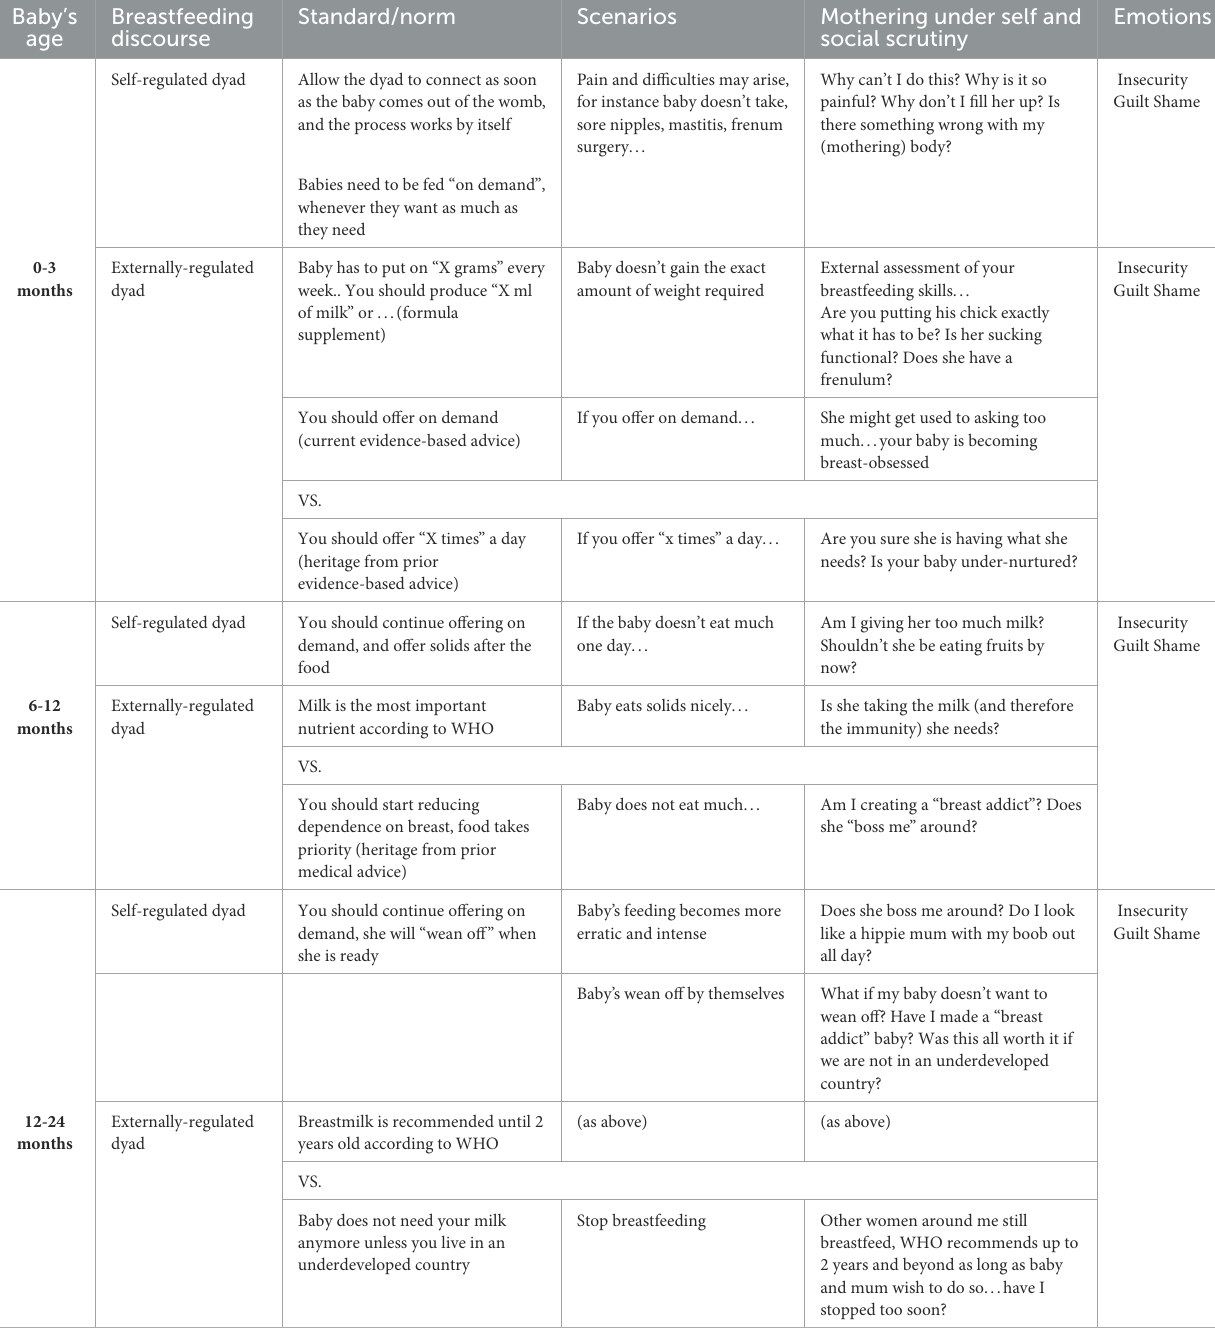
TABLE 1 Breastfeeding as the initiation act to the guilt-shame mothering spiral. Baby’s Breastfeeding age